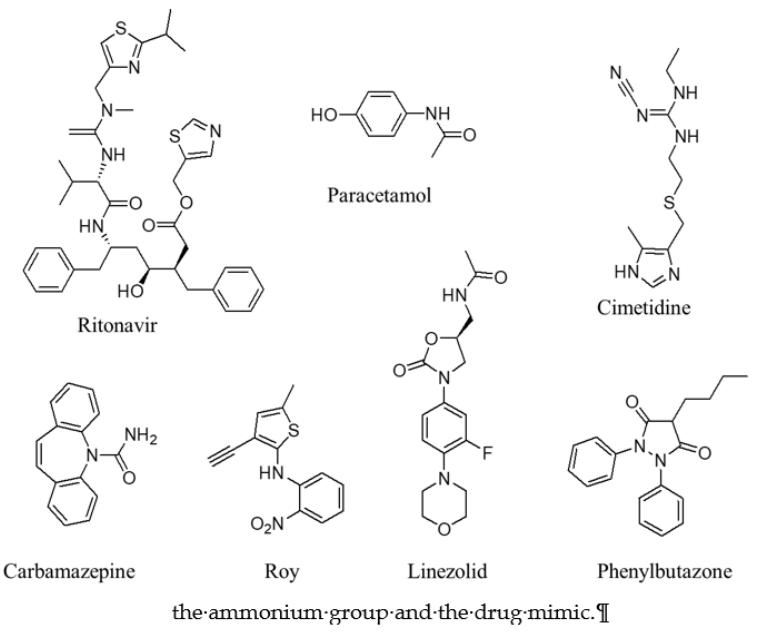
Figure 4. Structures of active pharmaceutical ingredients (APIs). The aromatic rings and alkyl part of these APIs can promote template-induced nucleation at the aromatic part (in acid) or alkyl chain (in amine part),